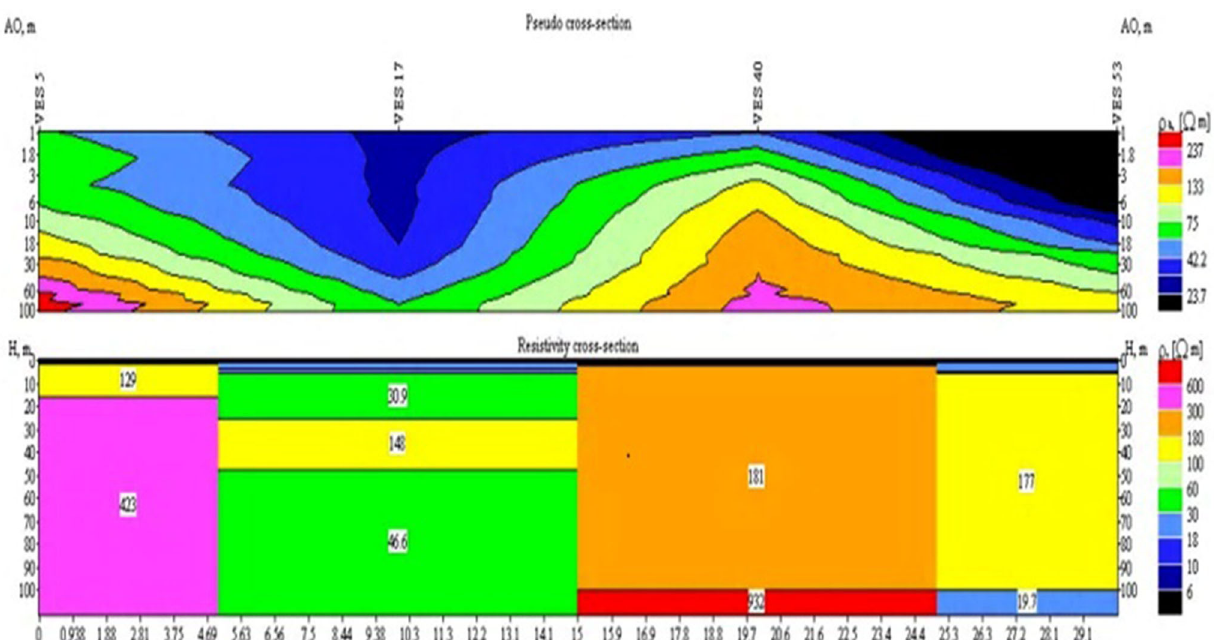
Fig. 13 Apparent and true resistivity geo-electric section along NW–SE from Dhule